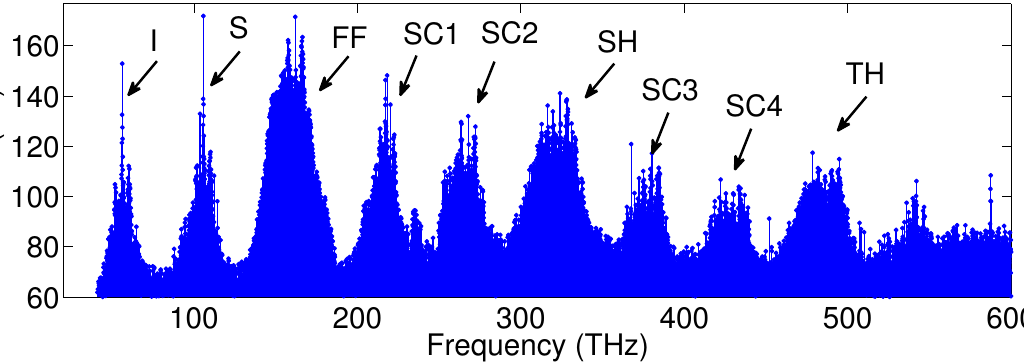
Figure 9. Numerical simulation of the single-envelope map when SHG and OPO processes are simultaneously phase matched in a lithium niobate microresonator pumped by 100 mW of cw power at 1850 nm. Reprinted with permission from [55] c (cid:13) The Optical